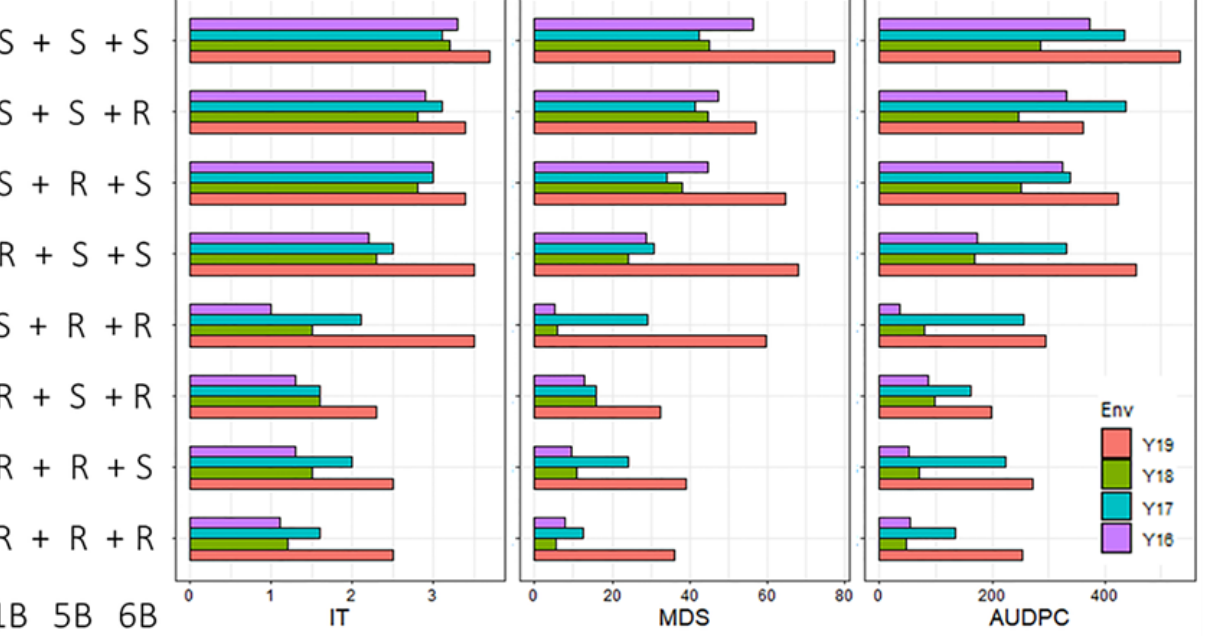
Figure 4. The accumulative effects of the QTLs identified in this study. 1B, 5B, and 6B indicate the three QTLs QYr.sdau-1B , QYr.sdau-5B , and QYr.sdau-6B , respectively. R and S indicate the resistance and susceptibility alleles of the identified QTLs. IT = infection type; MDS = maximum disease severity; AUDPC = area under the disease progress